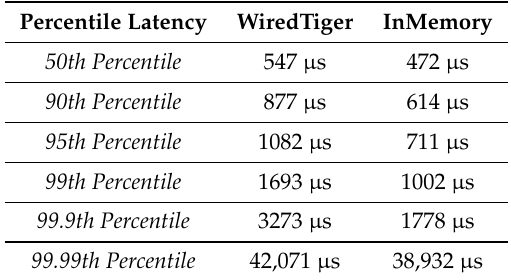
Table 4. Performance comparison on a PowerEdge server of 2 MongoDB stand-alone storage engines.